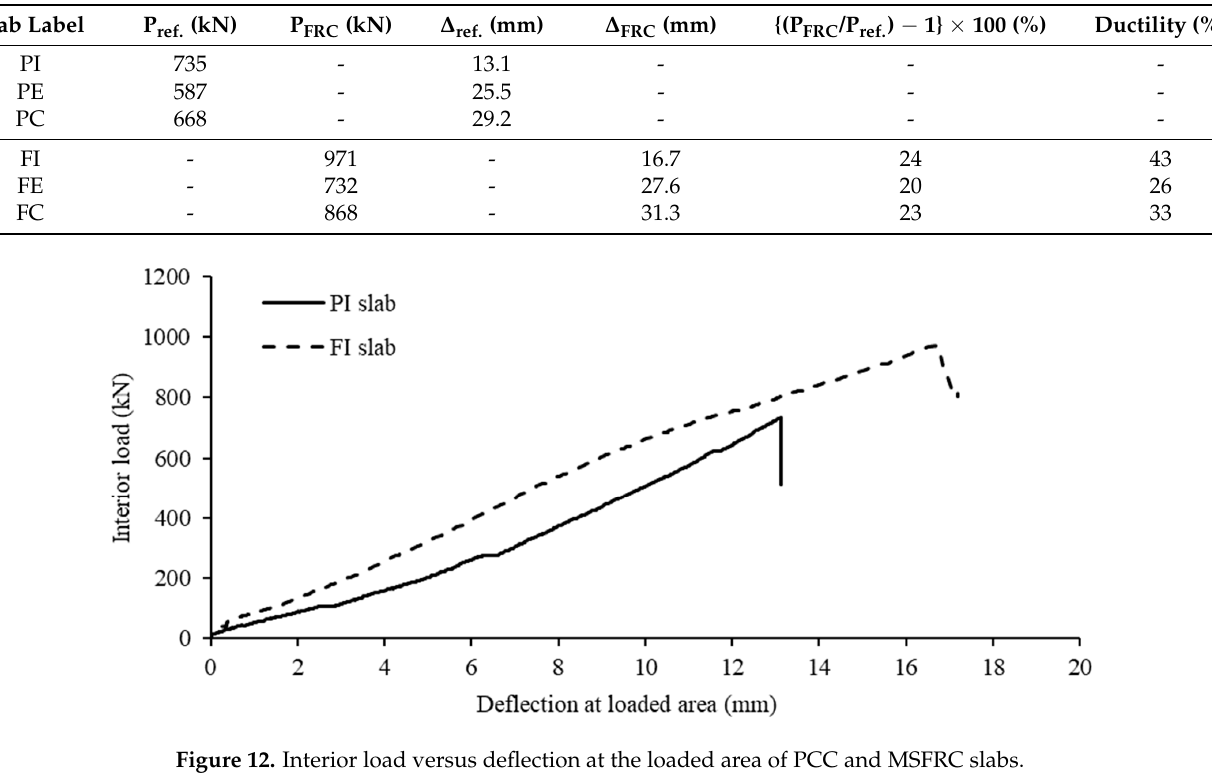
Figure 14. Corner load versus deflection at the loaded area of PCC and MSFRC slabs. 5. Conclusions Based on the results of this study, the following conclusions can be drawn: 1.